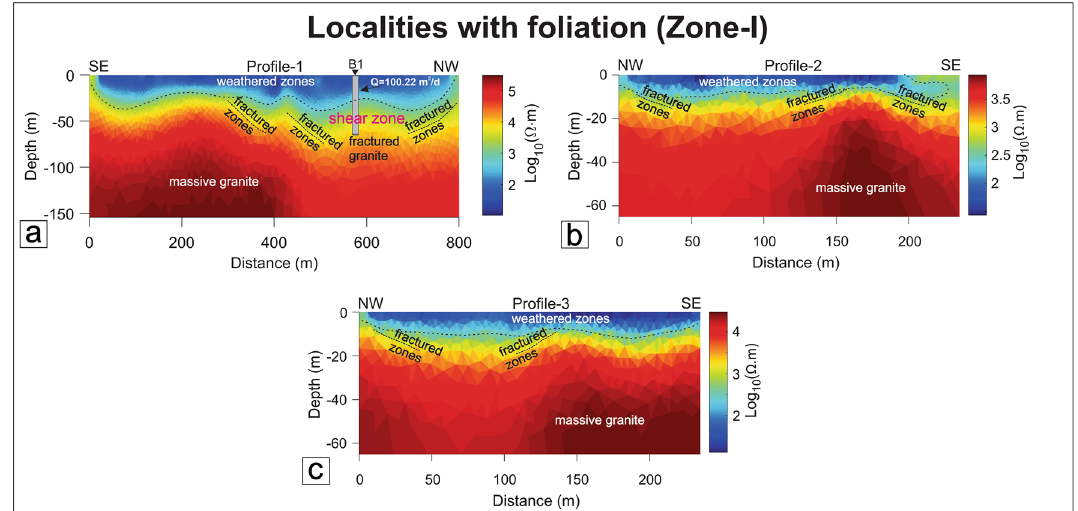
Figure 13. Resistivity profiles in Zone-I. ( a ) Profile-1, Surela area, ( b ) Profile-2, Surela area, ( c ) Profile-3, Ajapur Mota area. B1 shows the borehole location and the discharge rate (Q) in the Surela area.